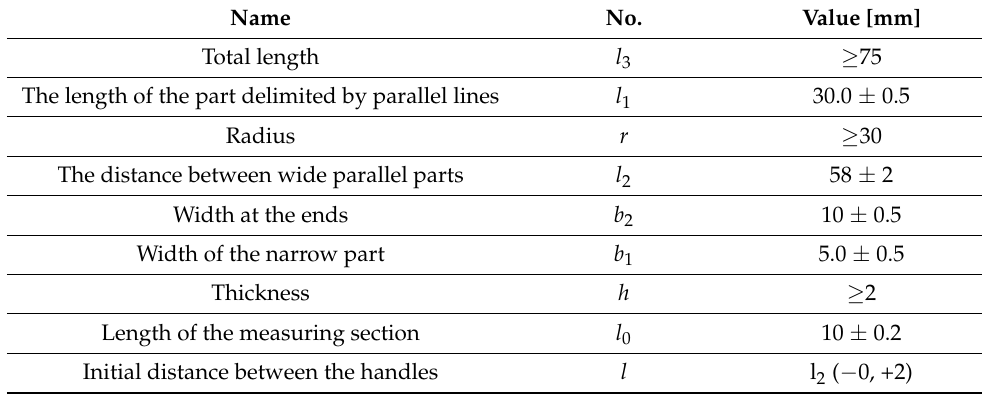
Figure 5. The geometry of the sample ISO EN ISO 527-2:2012 [49] (Table 1). Table 1. Dimensions of the sample ISO EN ISO 527-2:2012 [49].